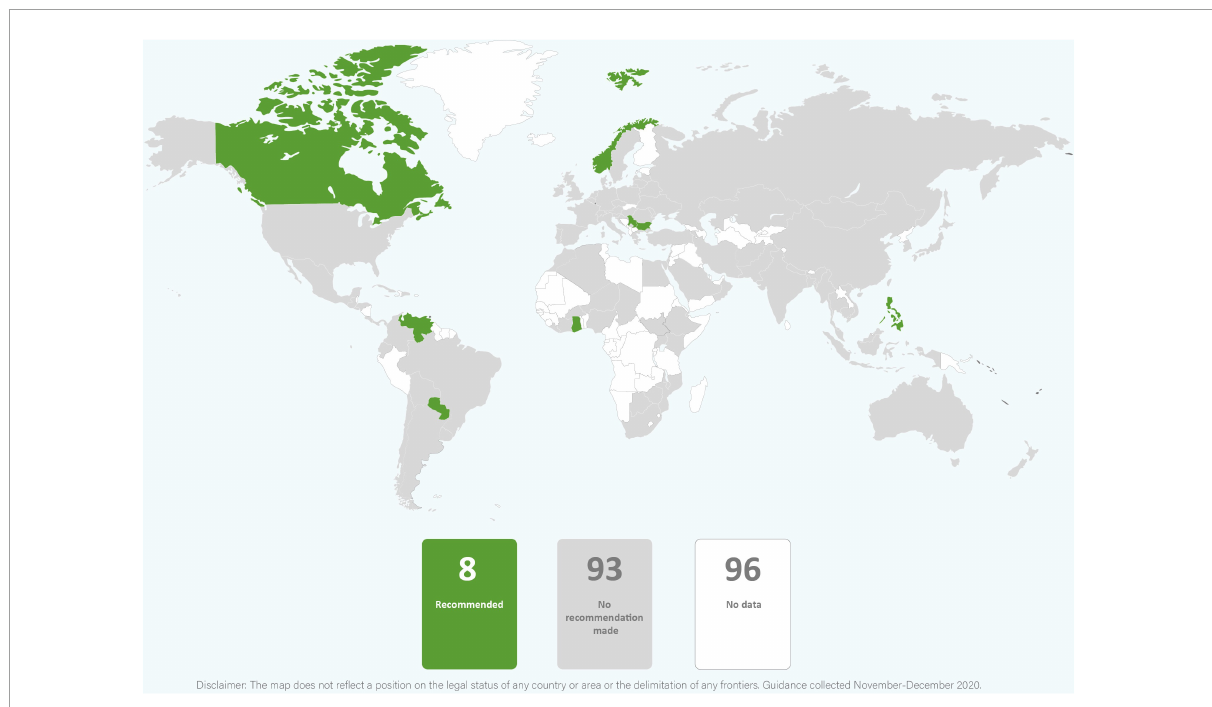
FIGURE8 Global distribution of recommendations on psychological support for infants of mothers with COVID-19 (data from 101 countries).